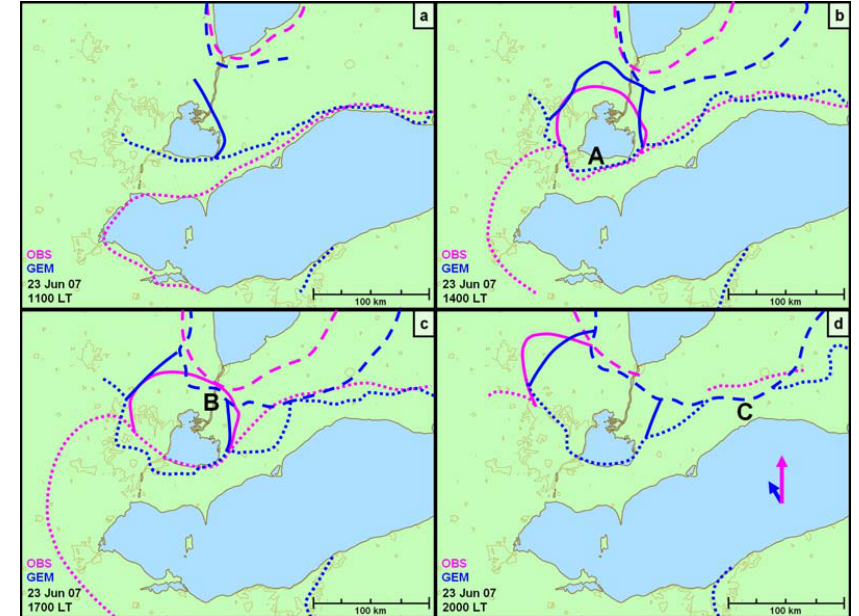
Figure 8. Observed (magenta) and GEM-LAM modeled (blue) features at four different times on 23 June 2007. Solid lines mark Lake St. Clair lake-breeze fronts, dotted lines Lake Erie lake-breeze fronts, and dashed lines Lake Huron lake-breeze fronts. Arrows on panel d show synoptic wind directions and relative synoptic winds speeds for the day. Locations A–C are discussed in the text.